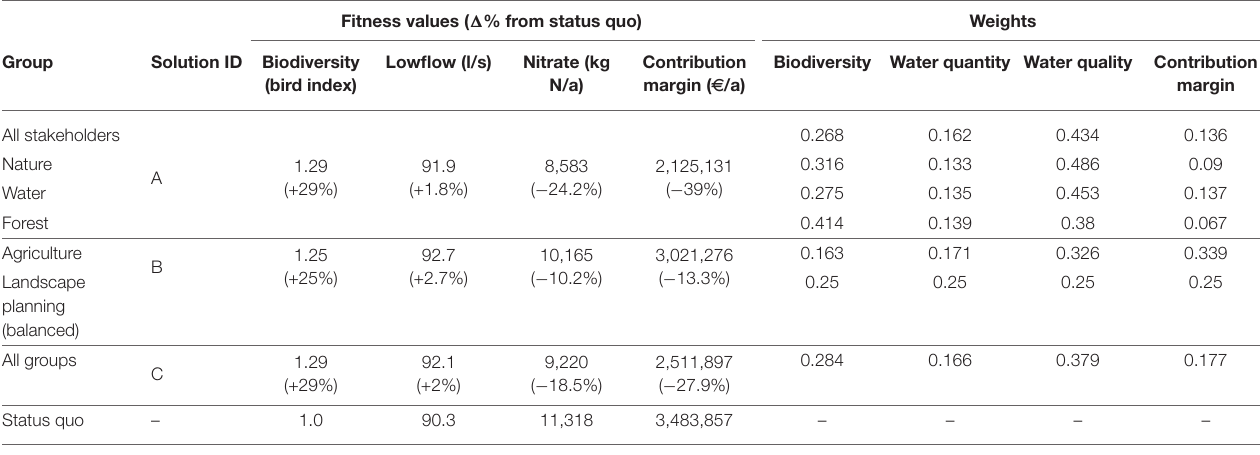
TABLE 3 | The different stakeholder groups, their relative AHP weights for the objective functions and the resulting best solutions with respective objective function fitness values (values in brackets show the percental change from status quo).